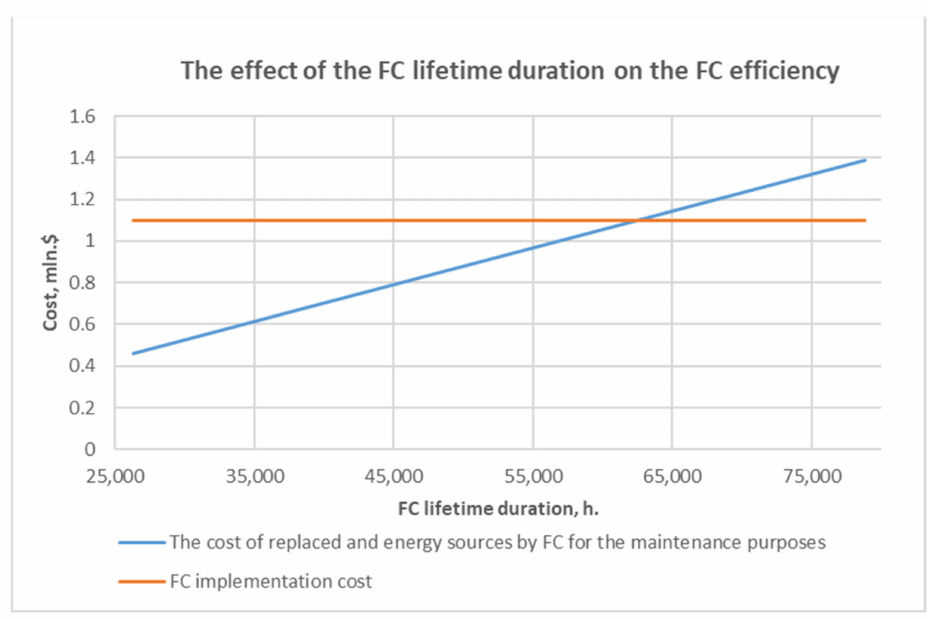
Figure 7. The effect of the FC lifetime duration on the FC efficiency in the case of covering the economic needs of the station by FC.